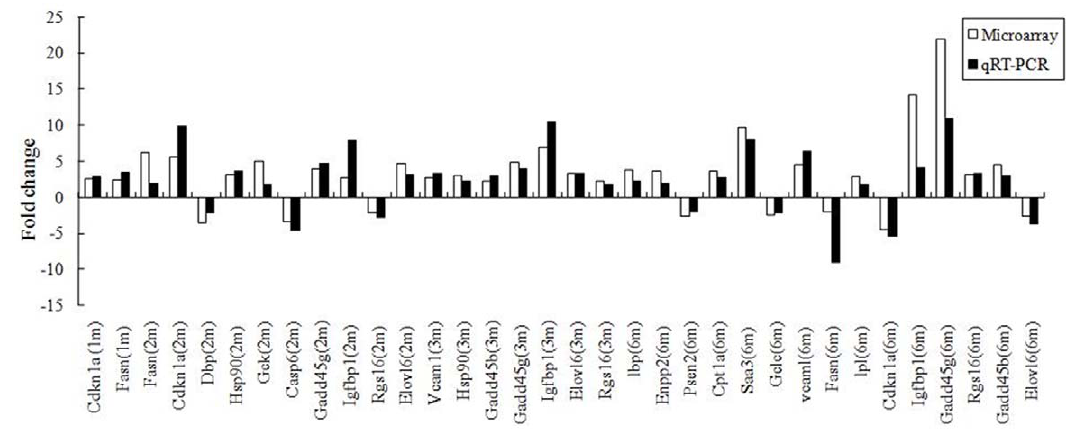
Figure 2. Validation of microarray data by qPCR on 19 randomly selected genes.